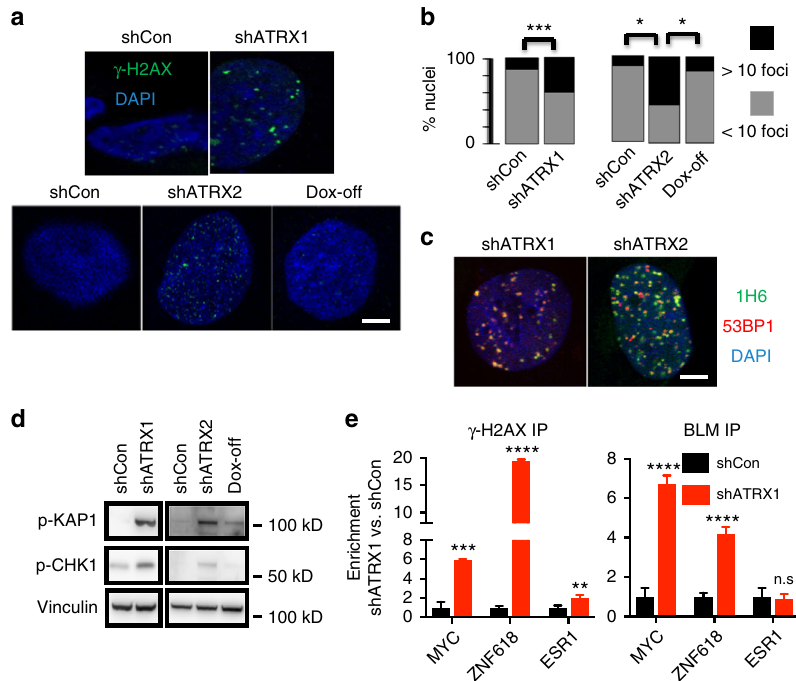
Fig. 2 ATRX de fi ciency promotes replication stress and DNA damage. a γ -H2AX immuno fl uorescence in constitutive (upper panel) and inducible (lower panel) NHAs (DAPI counterstain). b Quanti fi ed percentage of cells with >10 immunopositive γ -H2AX foci (50 nuclei counted in all cases). c NHAs with ATRX knockdown were double stained for G4 and 53BP1, showing extensive colocalization. d Western blots of p-KAP1 and p-CHK1 show activation of replication stress arising with ATRX knockdown. e γ -H2AX and BLM ChIP in shCon and shATRX1 NHAs (three replicates each) showing that ATRX de fi ciency promotes enrichment for both proteins at putative G4-rich promoter regions (MYC and ZNF618) far exceeding that seen at a negative control site (ESR1). Where applicable, error bars re fl ect SEM; P values determined by unpaired, two-tailed t -test (* P < 0.05, ** P < 0.01, *** P < 0.001, **** P < 0.0001, n.s.: P > 0.05); scale bars represent 10 µ